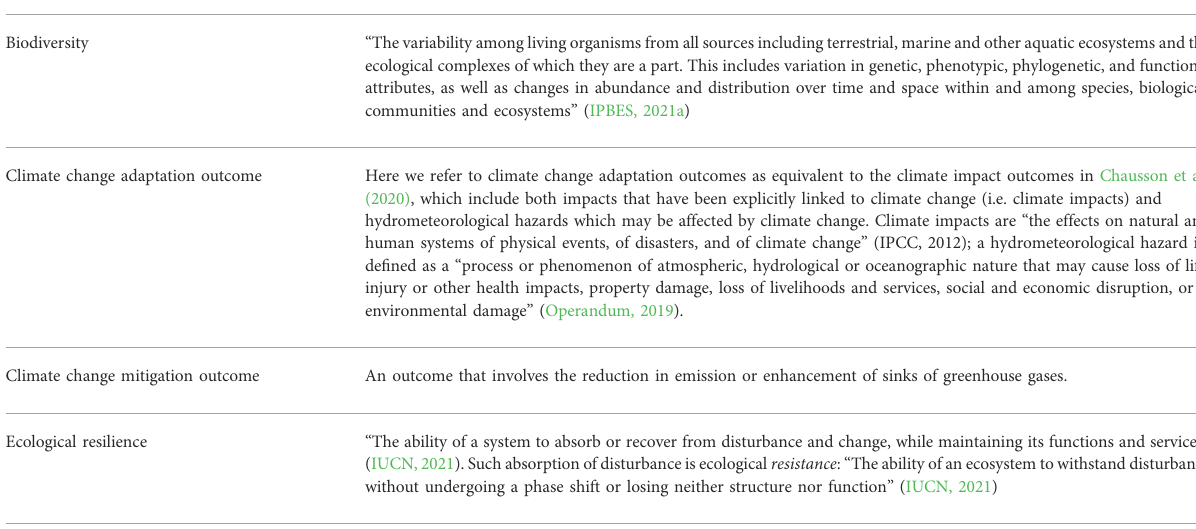
TABLE 1 De fi nitions of key social-ecological terms and intervention